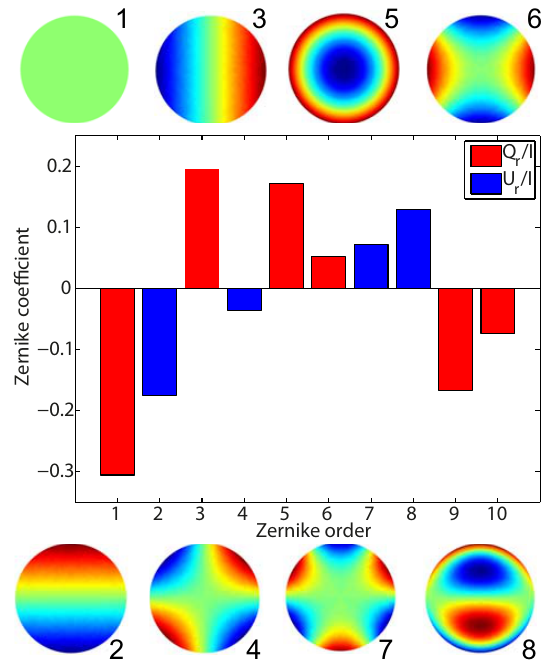
Fig. 4. The first ten Zernike coefficients for the maps of Q r / I and U r / I , defining the feature vector for 650nm. Shown above are polar plots of the first four symmetric Zernike polynomials (order 1, 3, 5 and 6) yielding the coefficients for the maps of Q r / I . The anti- symmetric Zernike polynomials (order 2, 4, 7 and 8) yielding the coefficients for the maps of U r / I are shown at the bottom. The polar axes are the same as for the Stokes maps in Figs. 1–3. Table 2. AODs used for modeling the aerosol scenarios. The AOD at 450 nm determines the AOD at 550nm and 650nm by the ˚Angstr¨om relation with α = 1 . 5 for fine mode dominated urban and biomass burning aerosol and α = 0 . 5 for coarse mode dominated desert and oceanic aerosol. AOD 550 AOD